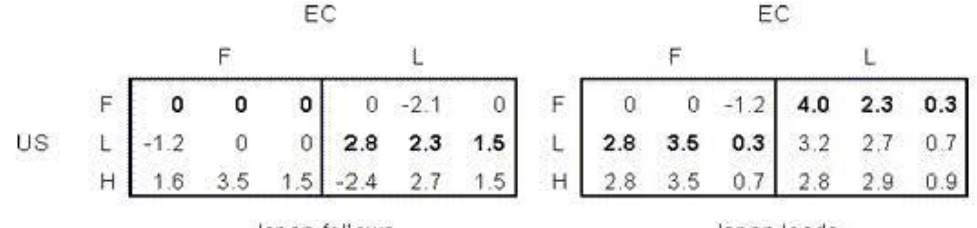
Table 5.1 The game in 1975 with c=2.4 and cr